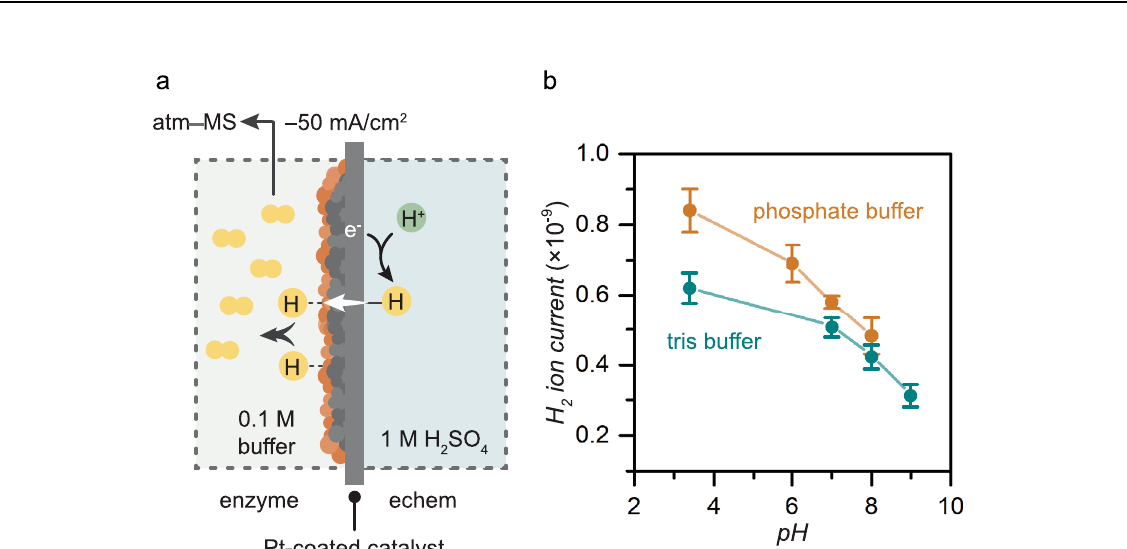
setups. Each enzyme solution contains 1mg/mL BSA. Error bars represent the standard deviation of triplicate measurements. The center point of each error bar represents the mean of the triplicate measurements.